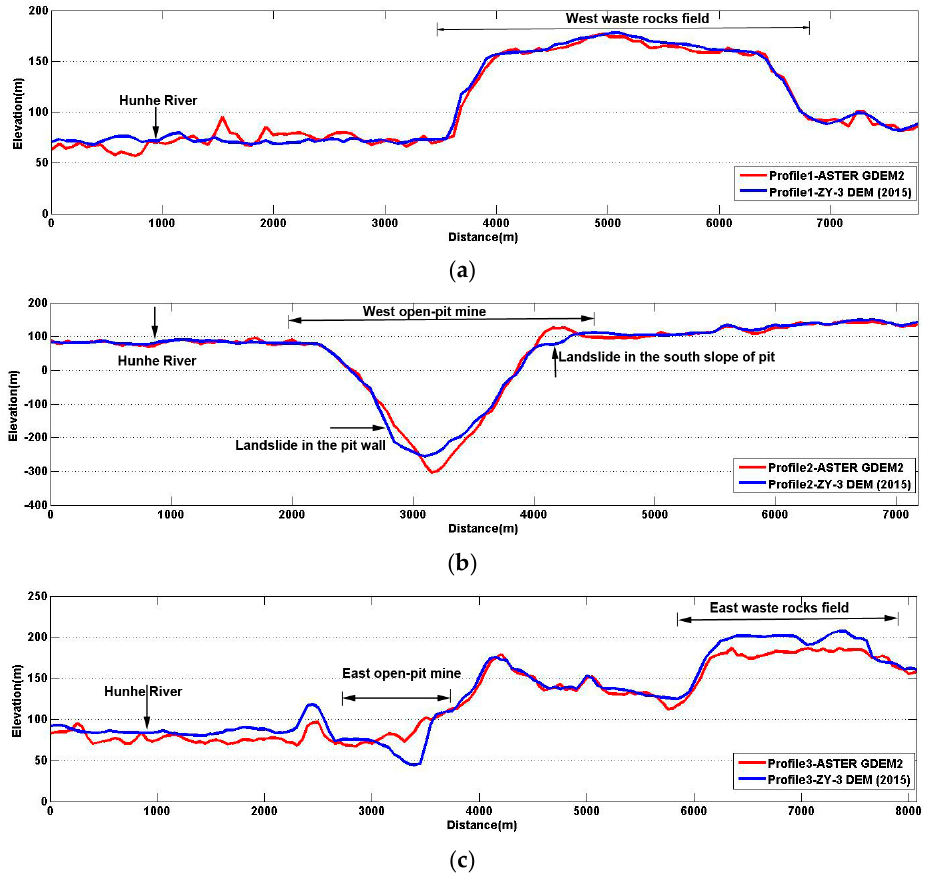
Figure 9. Topographic deformation along three profiles that cross the active open mining pit and the waste rocks field. ( a ) Topographic deformation along Profile 1, ( b ) Profile 2, and ( c ) Profile 3.